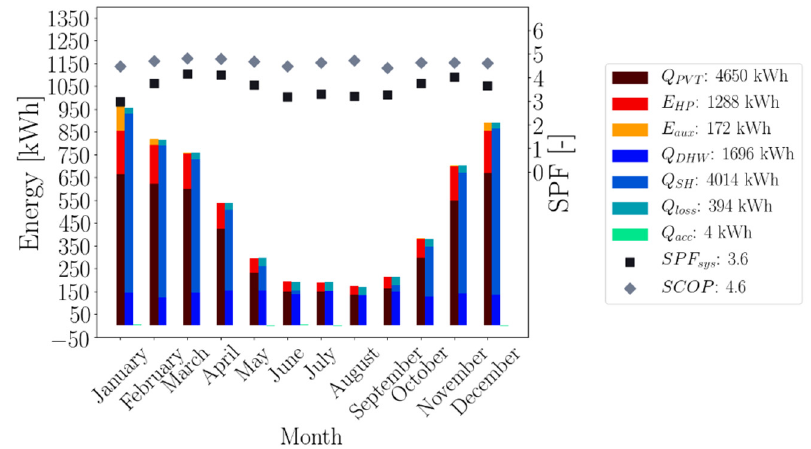
Figure 9. Monthly seasonal performance factor ( SPF ), seasonal coefficient of performance ( SCOP ) of the heat pump and the system’s energy balance.